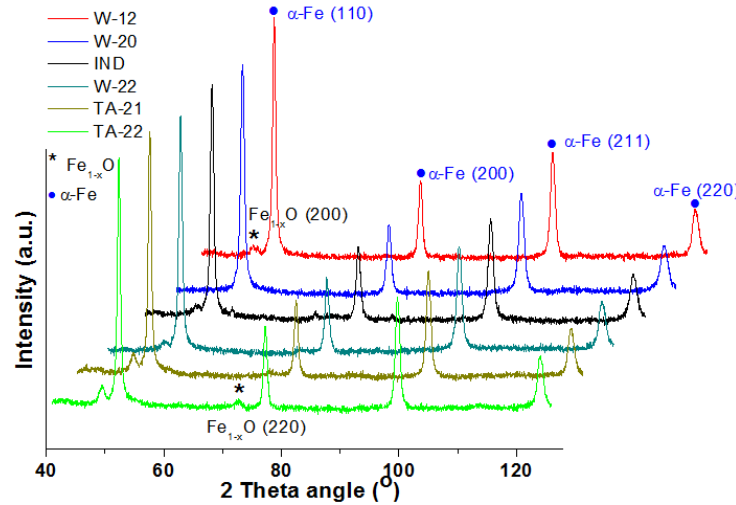
Figure 4. XRPD patterns of the catalysts obtained after reduction of precursors at 500 °C.